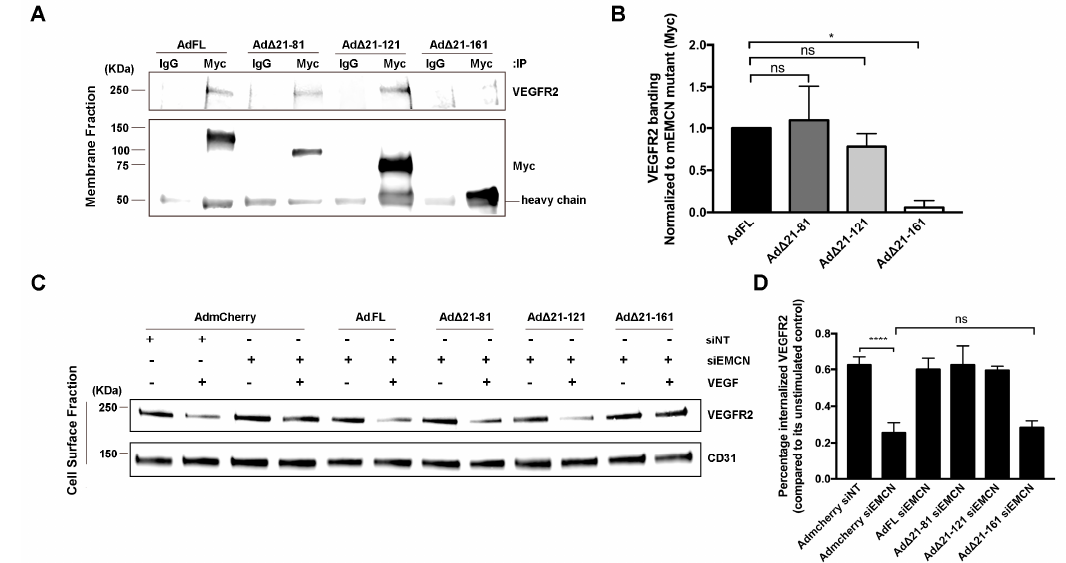
Figure 3. Δ 21-161 EMCN does not interact with VEGFR2 or rescue VEGFR2 internalization. ( A , B ) Membrane proteins of HRECs lacking endogenous hEMCN and overexpressing the different Myc-tagged mEMCN constructs were extracted and subjected to co-immunoprecipitation (co-IP) using anti-Myc antibody, and the protein levels of VEGFR2 and the different mEMCN mutant proteins were examined by western blot. The FL EMCN, Δ 21-81, and Δ 21-121 all co-IP’ed with VEGFR2 whereas Δ 21-161 did not. ( C , D ) To assess VEGFR2 internalization, cell surface proteins were labeled using NHS-SS-biotin and isolated, and protein levels of VEGFR2 and CD31 were analyzed by western blot. The FL EMCN, Δ 21-81, and Δ 21-121 all rescued VEGFR2 internalization; Δ 21-161 did not. All data = mean ± SEM, ns, not significant, * p < 0.05, **** p < 0.0001 by 2-tail unpaired t-test, n = 4.